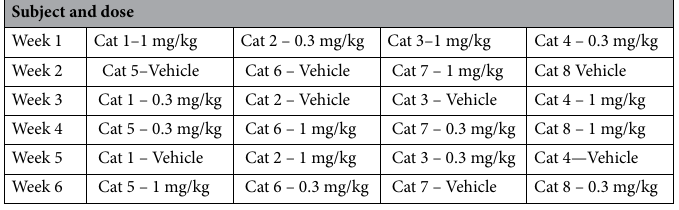
Table 6. Cross-over study